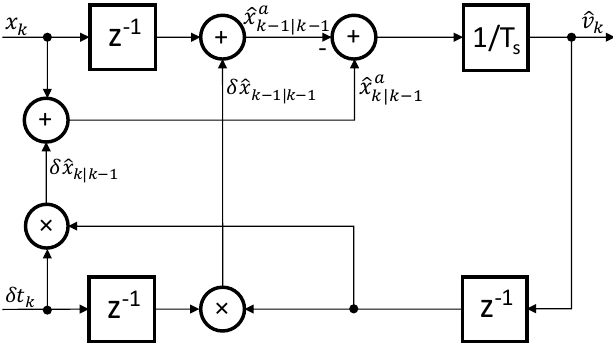
Figure 6. The block scheme of the improved MT-type division-less algorithm.